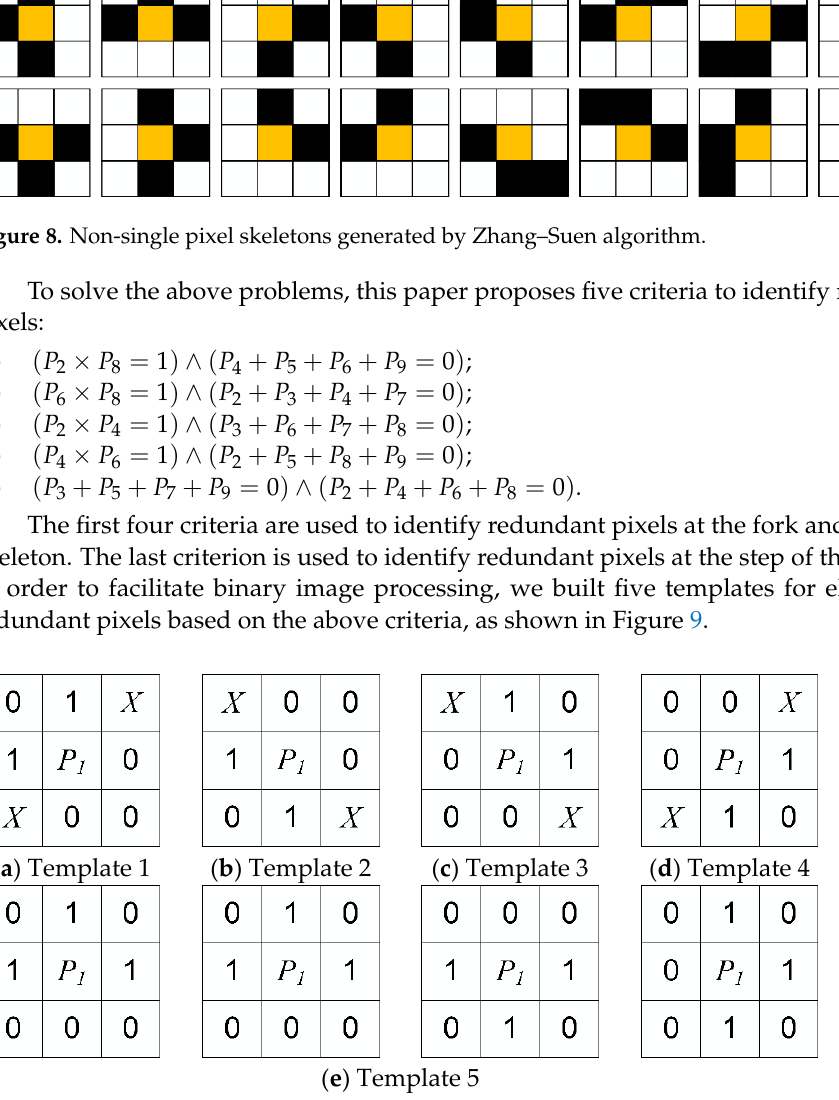
Figure 9. The templates for removing redundant pixels.